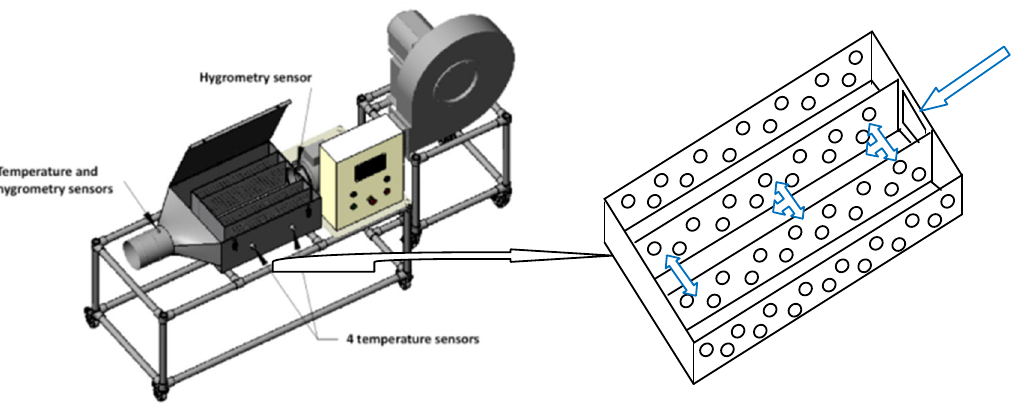
Figure 2. Pilot dryer and drying chamber.